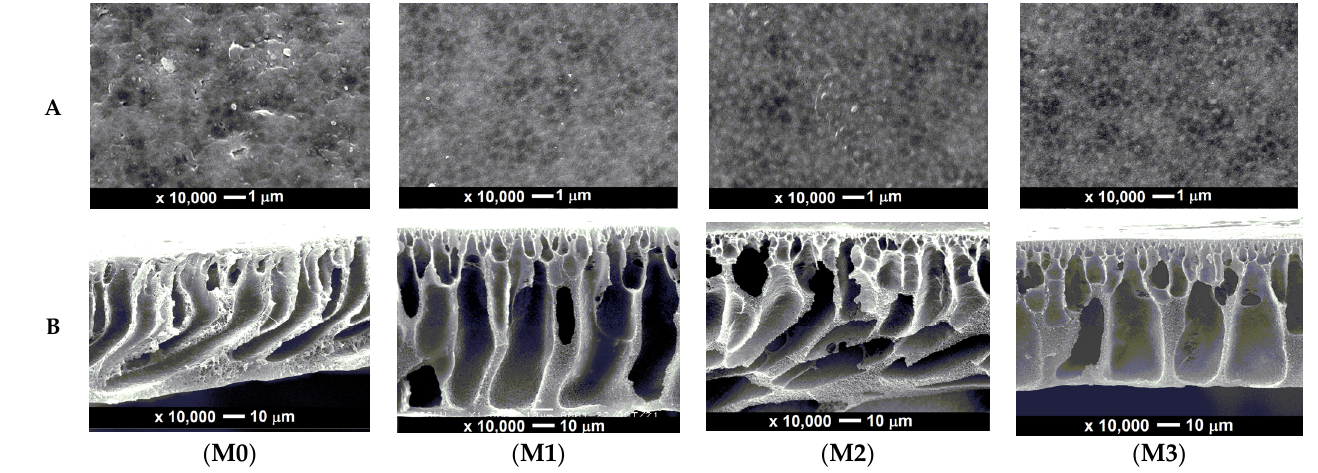
Figure 3. Morphological structure of the surface ( A ) and cross-section ( B ) membranes: (M0) pure PVDF, (M1) PVDF with Pol, (M2) PVDF with Pol and S-CnT, and (M3) PVDF with Pol and M-CnT. The membrane sample was coated with osmium powder for 30 min, and the SEM imaging magnification was 1000 and 10,000 for cross-section and surface structure, respectively.